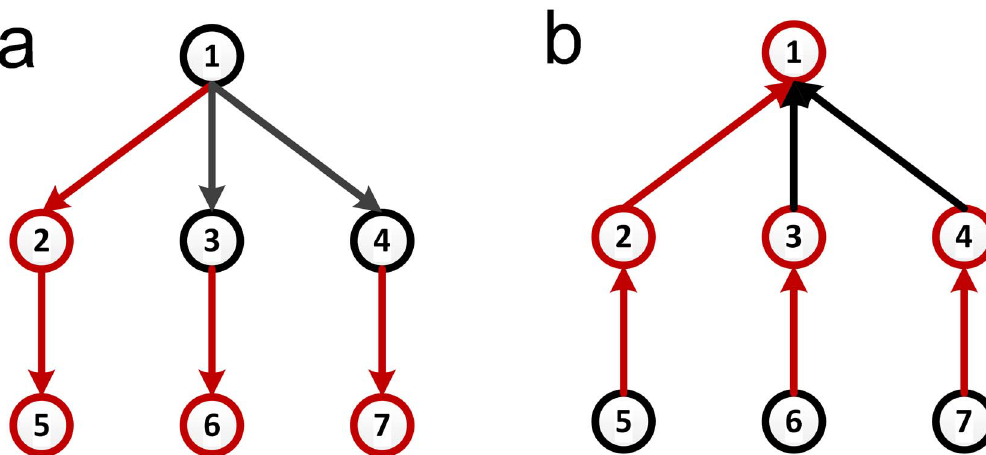
Figure 4. Two simple networks with , k . =1.857. Red nodes and edges are matched by a maximum matching. Black nodes and edges are driver nodes and unmatched edges. The average degrees of the MDSs of networks (a) and (b) are 2.33 and 1, respectively.